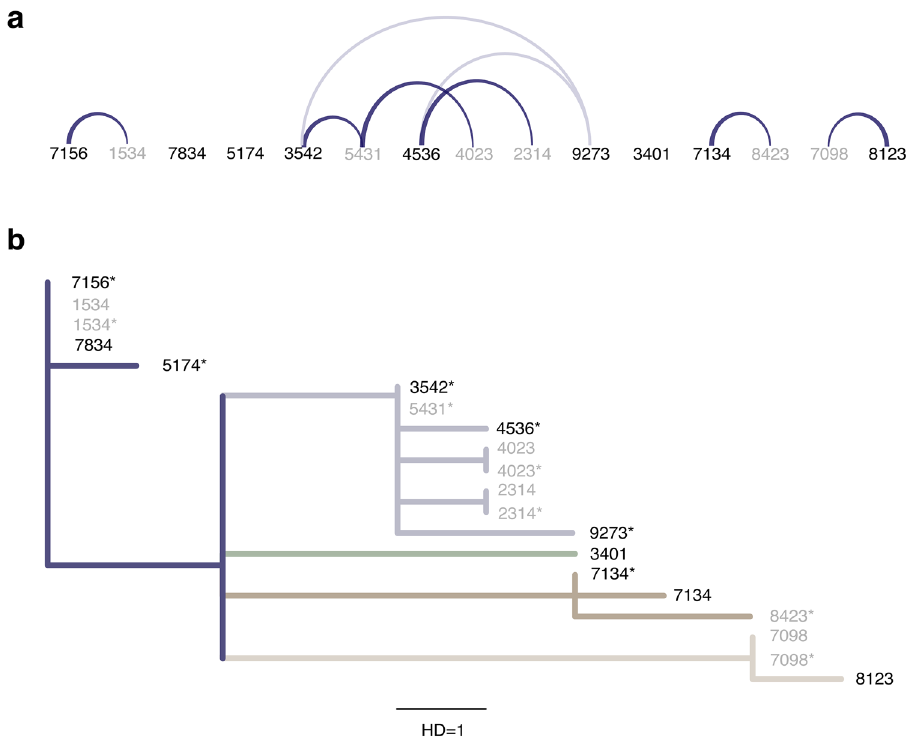
Figure 3. Contact tracing record arc diagram ( a ) and maximum likelihood tree ( b ) of initial 15 cases prior to a church outbreak in South Korea. ( a ) Confirmed close contacts via epidemiological tracing are linked with a solid curve, with the transmission directionality (from case 8123 to case 7098, for example) indicated by width (wide: source; narrow: recipient). Potentially exposed pairs of individuals (within the same relative area) are marked with faded curves (for example, between Case 4536 and Case 9273). Imported (local) cases are presented by solid (faded) numbers. ( b ) Five transmission clusters inferred via maximum likelihood tree analysis on the SARS-CoV-2 whole genome sequences from the 15 cases: from top to bottom, cluster 1 (blue), cluster 2 (light blue), cluster 3 (green), cluster 4 (brown), cluster 5 (light brown). A star denotes sequences obtained by virus inoculation and cell culture. The length of the black bar indicates a Hamming distance (HD) of 1 or a one nucleotide base difference. The branch support values of the tree using the SH-like likelihood ratio test were estimated as around